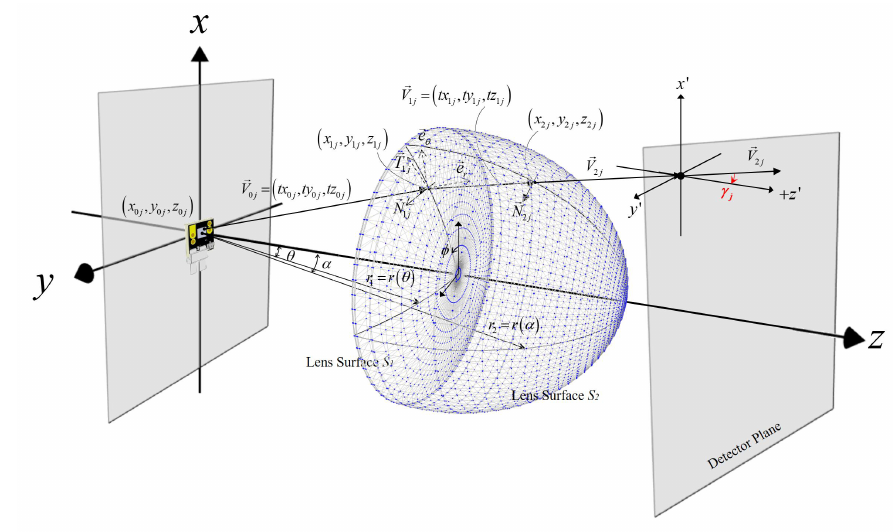
Figure 3. Analyze rays emitted from a LED chip and refracted by the designed light collimating